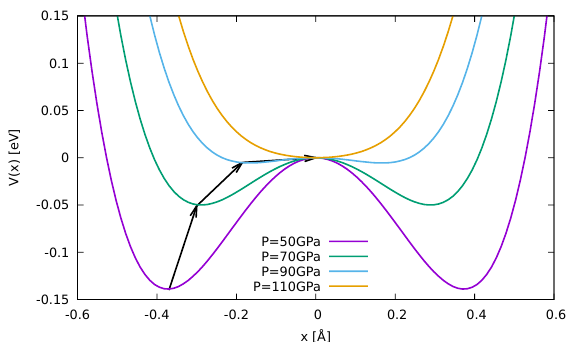
Figure 3. Potential energy of the system as a function of the hydrogen atom position x between its two neighbouring oxygen atoms for several pressures. The transition mechanism for ice is shown from a classical viewpoint: as pressure is increased, the two potential wells move closer and the barrier eventually vanishes.